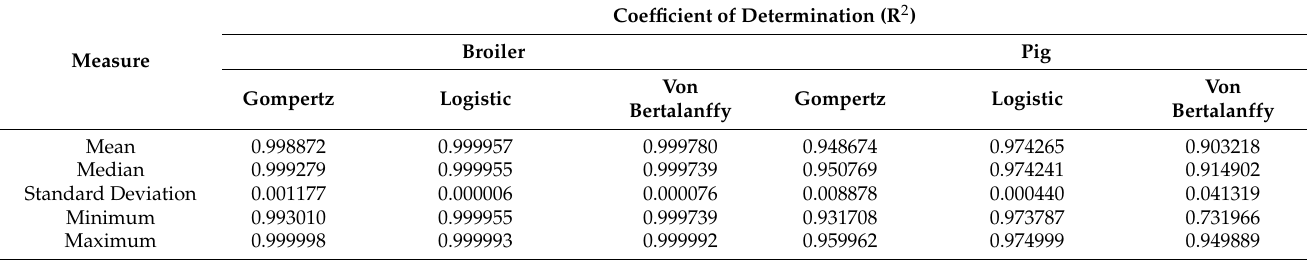
Table 7. Performance of SAGAC in 300 trials for each model related to the dispersion obtained for each assay for all